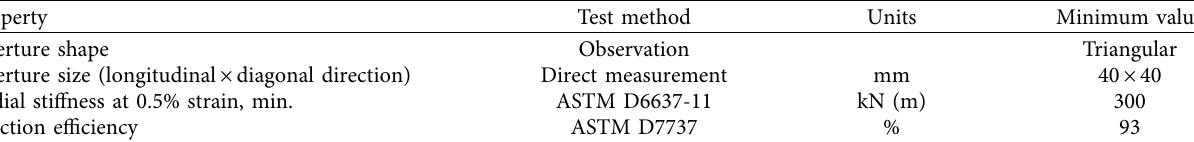
Table 2: Summary of geogrid material mechanical properties.